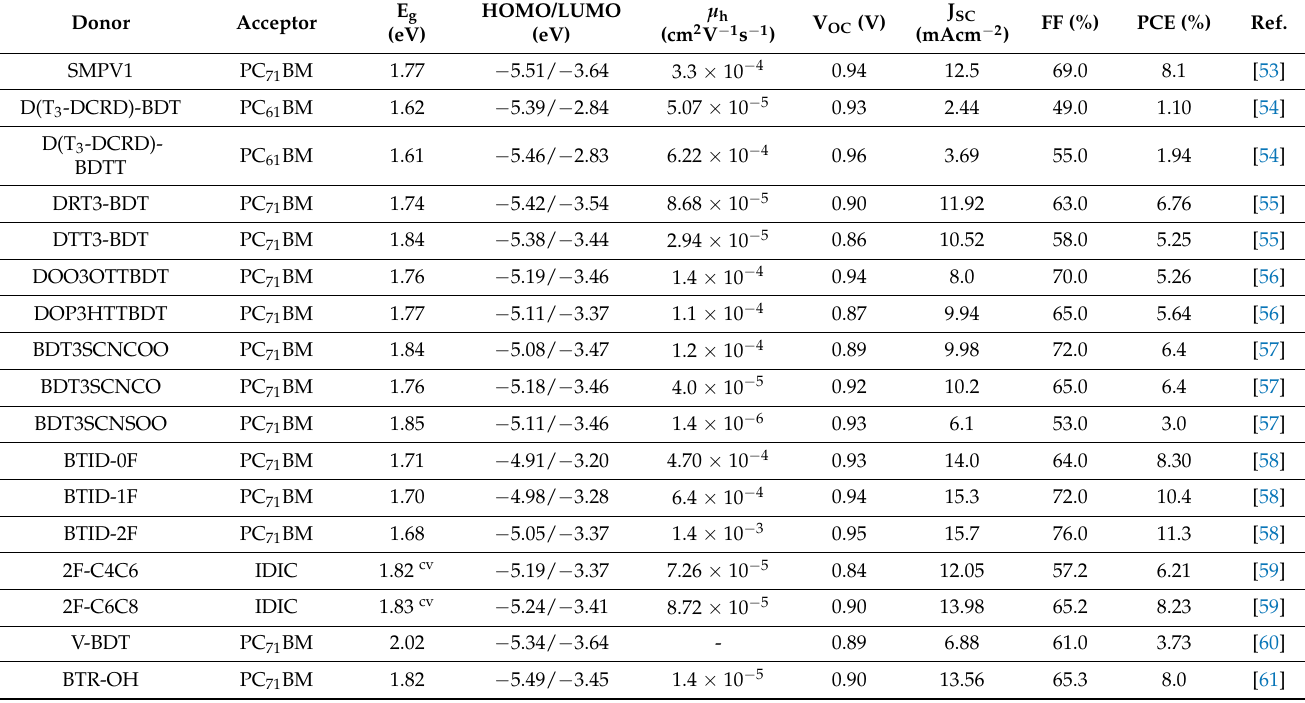
Table 2. Optoelectronic properties and device parameters for BDT-based ASM OSCs via end group